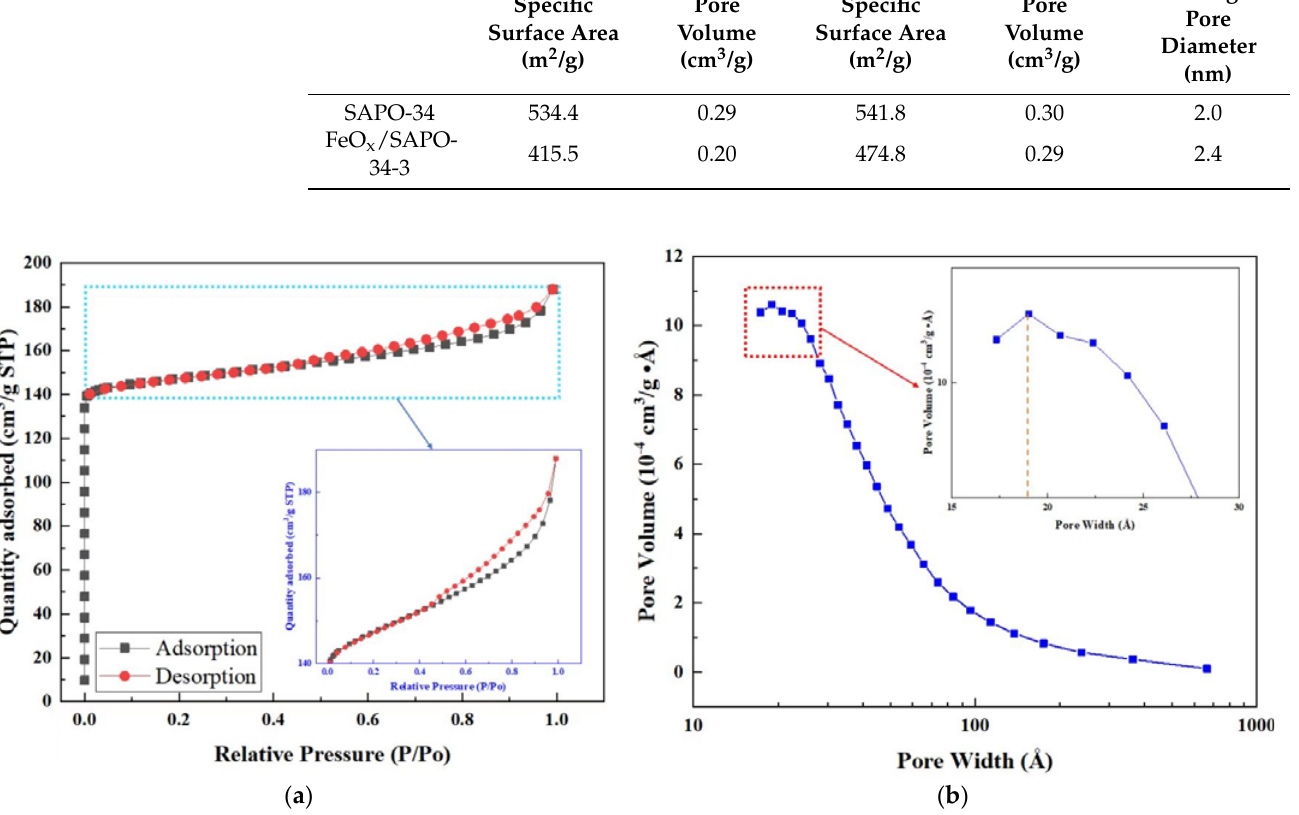
Figure 3. The FeO x /SAPO ‐ 34 ‐ 3 molecular sieve sample: ( a ) N 2 adsorption–desorption isotherms; ( b ) Pore size distribution.